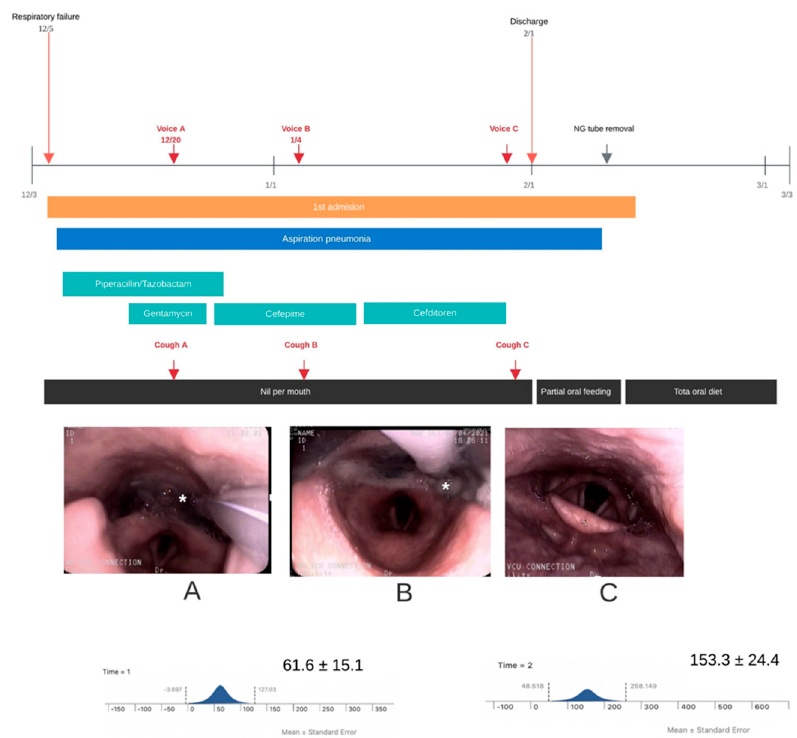
Figure 2. The timeline shows the clinical course of Case 2, with images taken during the FEES examination showing secretion aspiration (asterisk), but with improved swallowing after tube removal and improved peak cough flow. The times at which cough sounds were recorded are shown with cough ( A ) at baseline, ( B ) at follow-up but still with poor cough and cough ( C ) at improvement. FEES = fiberoptic endoscopic evaluation of swallowing; NG = nasogastric.